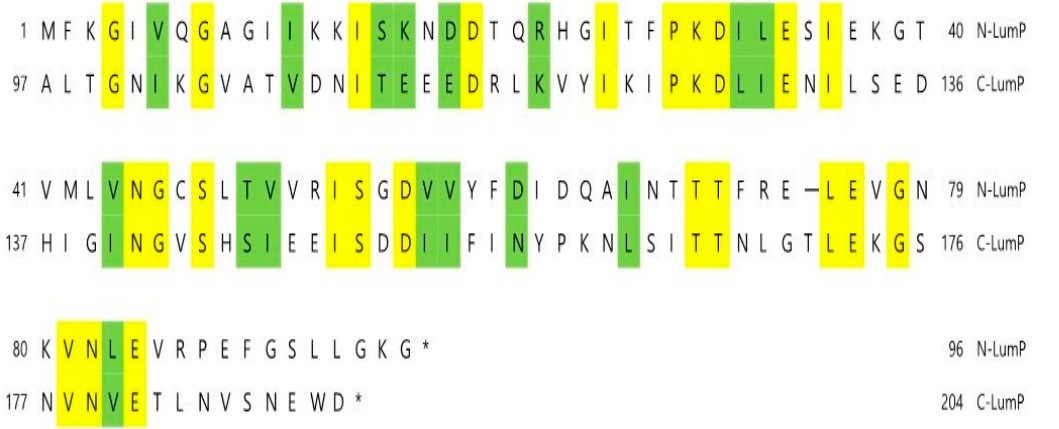
Figure 4. Amino acid sequence homology between the N-terminal half of lumazine protein (N-LumP) and the C-terminal half of lumazine protein (C-LumP) from P. phosphoreum NCMB844. Identical or similar amino acids are shown boxed by yellow and green, respectively. The bar and asterisks indicate amino acid gaps and stop codons,